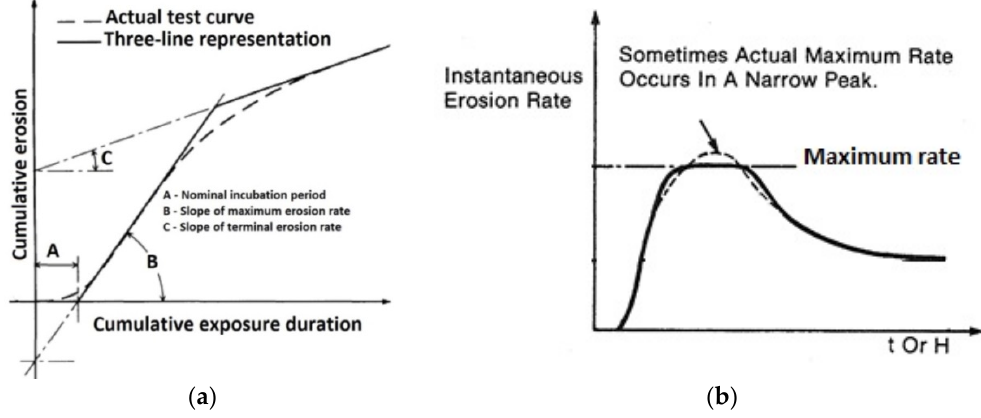
Figure 6. WDE curve analyses using ( a ) three line representation [33] and ( b ) ER inst